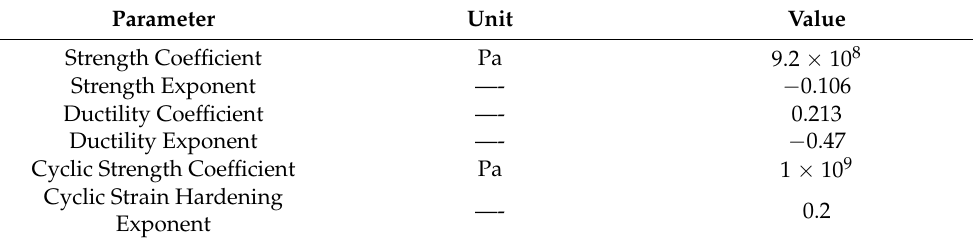
Table 3. LCF properties of structural steel based on the strain-life criterion [7]. Parameter Unit Strength Coefficient Strength